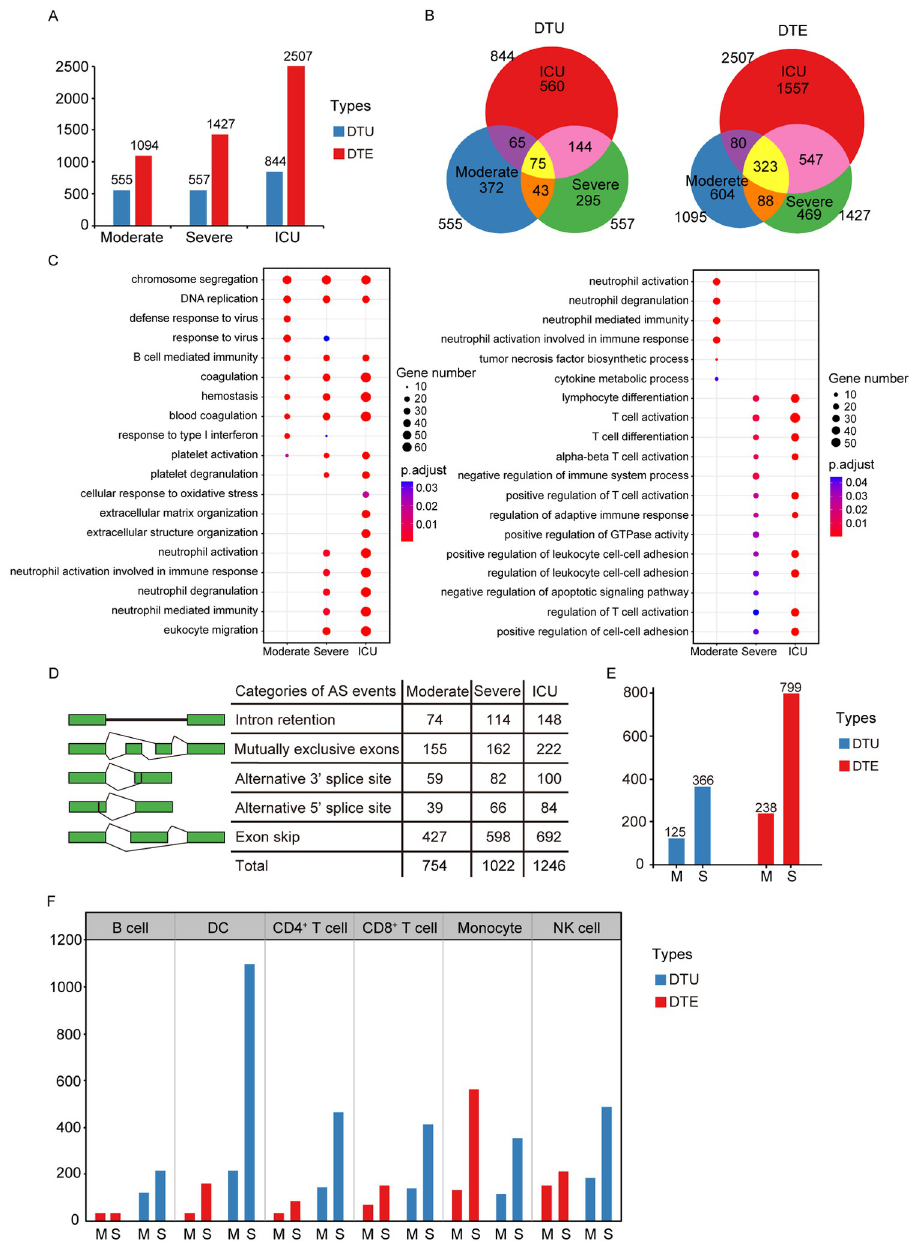
Fig 5. Transcriptional profiling reveals widespread dysfunction of cellular gene expression in PBMCs of COVID- 19 patients. (A) Histogram diagram depicts number of DTU and DTE transcripts across three COVID-19 stages. (B) Venn diagrams depict overlap among DTU or DTE transcripts across three COVID-19 stages. (C) Dotplot visualization of the enriched GO terms of upregulated (left) and down-regulated (right) DTEs in the lungs of COVID- 19 deceased patients. The color of the dots represents the p value adjusted by Benjamini–Hochberg correction for each enriched GO term identified by Fisher’s exact test using enrichGO function in R package clusterProfiler, and the size of the dot represents the number of genes enriched in the total gene set. (D) A schematic representation of 5 types of AS events and the number of genes with defined AS events in the moderate, severe and ICU COVID-19 cases compared with controls. (E) Histogram diagram depicts number of DTUs and DTEs across different COVID-19 stages in Lee et al.’s cohorts. M, Mild; S, Severe. (F) The histogram diagram depicts number of DTUs and DTEs across different COVID-19 stages in specific cell types. M, Mild; S,